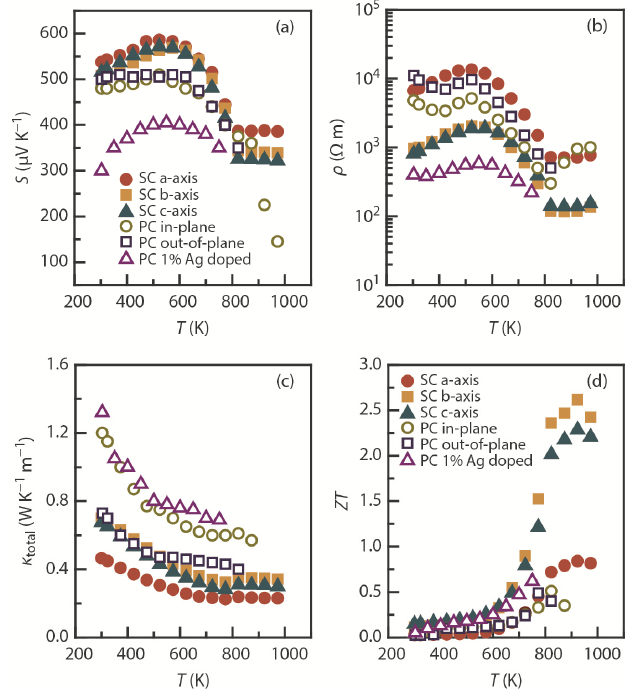
Figure 12. Temperature dependence of the ( a ) Seebeck coefficient ( S ); ( b ) electrical resistivity ( ρ ); ( c ) total thermal conductivity ( κ total ); and ( d ) thermoelectric figure of merit ( ZT ) for single-crystal (SC) SnSe measured along the a -, b -, and c -axis [35], polycrystalline (PC) SnSe in the in-plane (crystalline bc -plane) and out-of-plane (crystalline a -axis) directions [117], and 1% Ag-alloyed polycrystalline SnSe in the in-plane direction